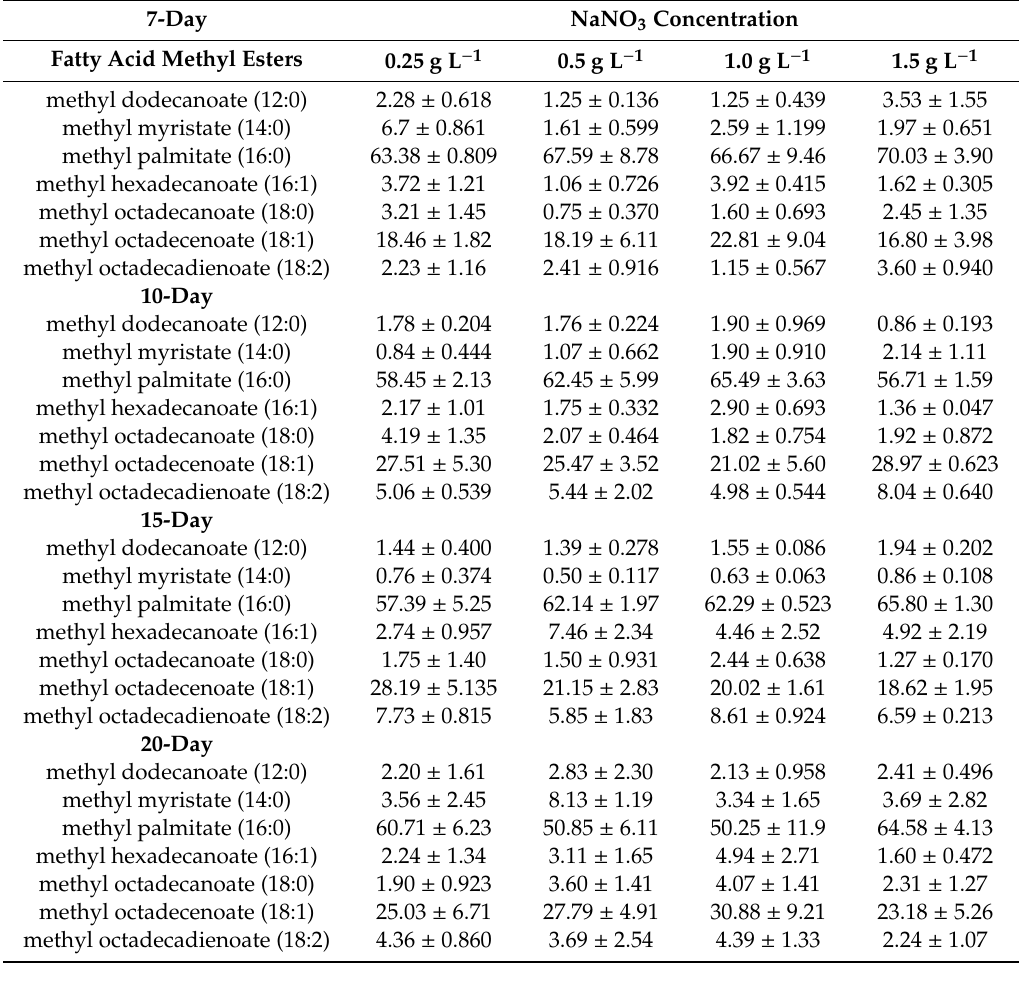
Table 1. Fatty acid methyl ester (FAME) composition in Fremyella diplosiphon grown over 7, 10, 15, and 20 days in media containing 0.25, 0.5, 1.0, 1.5 g L − 1 sodium nitrate (NaNO 3 ) based on relative abundance of each component (% total extractable FAMEs ±